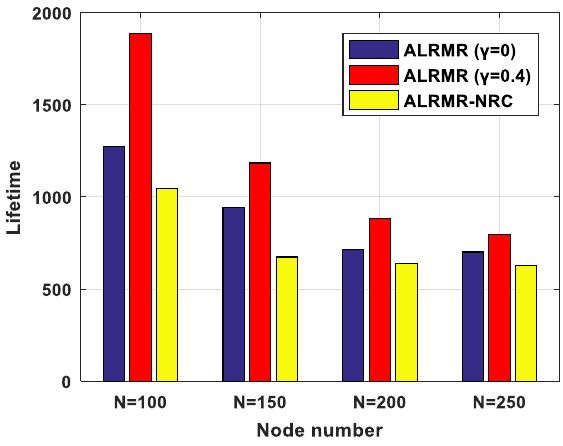
Figure 6. Lifetime with different node numbers.